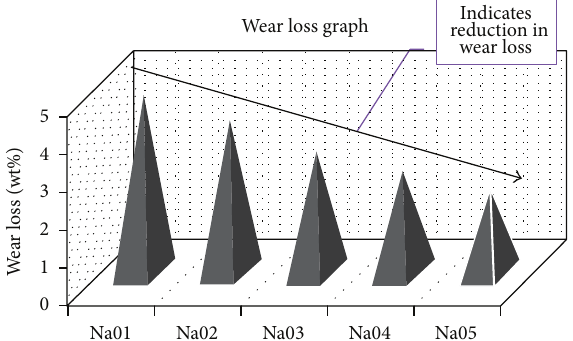
Figure 12: Wear loss by wt% of the various compositions.